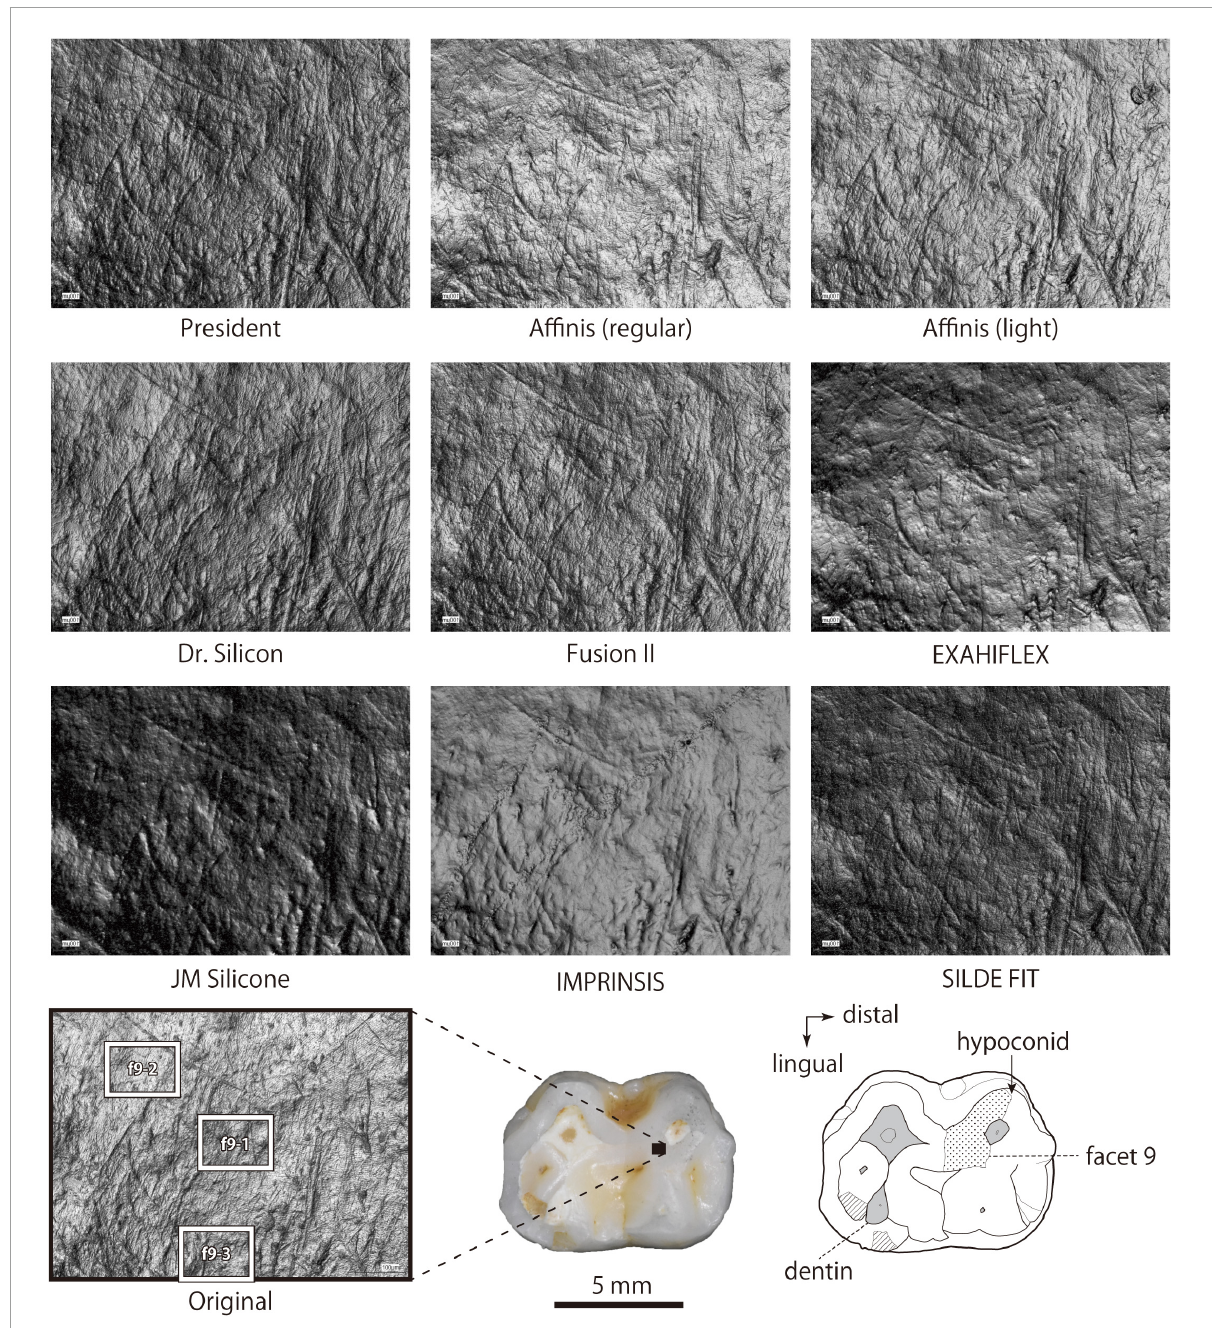
FIGURE1 Comparison of dental impressions among nine impression materials. 2D images were obtained by a confocal laser microscope equipped with a 20 × objective lens. The size of each image is 540 µ m × 725 µ m. An occlusal view of the right lower second molar of the Japanese macaque used in this study is shown in the right lower photo and schema. The black rectangle on the tooth photo indicates the area where we obtained silicone impression molds. The white rectangles in the 20 × tooth surface image obtained from the original tooth indicate the locations (f9-1, 2, and 3) where higher magnification images and 3D texture data were acquired. Wear state and location of facet 9 are shown in the